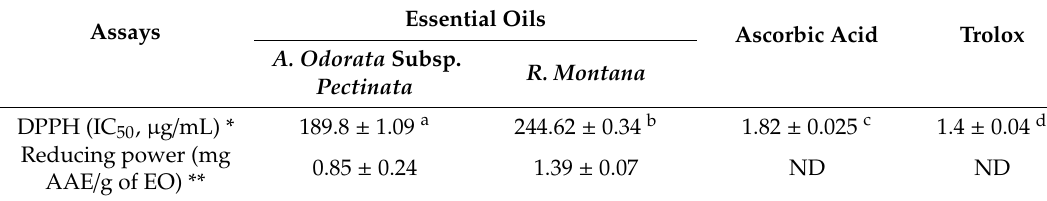
Table 2. Antioxidant activity of A. odorata subsp. pectinata and R. montana essential oils. Essential Oils Assays Ascorbic Acid Trolox A. Odorata Subsp. R. Montana Pectinata Reducing power (mg 0.85 ± 0.24 1.39 ± 0.07 ND ND AAE / g of EO) ** Values represent means (standard deviations) for triplicate experiments; values with di ff erent superscripts (a–d) were significantly di ff erent at p < 0.05. * IC 50 : the concentration at 50% of inhibition. ** mg AAE / g EO: milligram equivalence of ascorbic acid per gram of essential oil; ND: not determined.